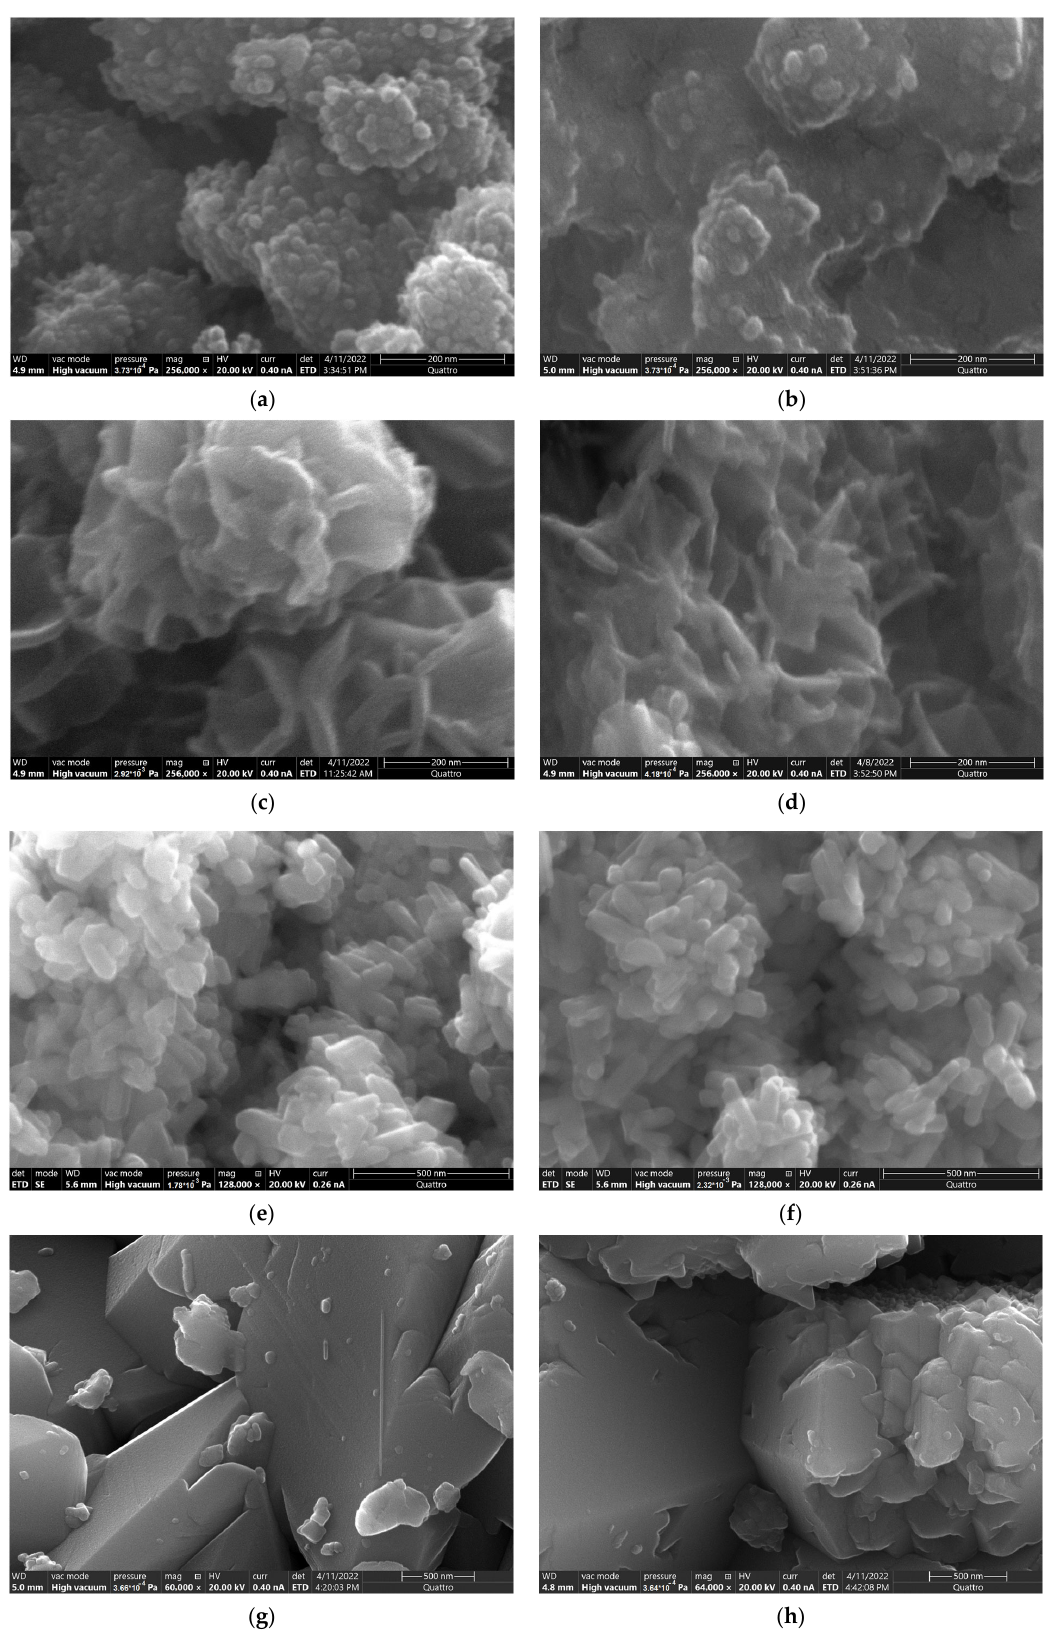
Figure 3. SEM microphotographs of MnO 2 polymorphs’ surfaces before and after Mn adsorption: ( a ) AKH; ( b ) AKH + Mn; ( c ) BIR; ( d ) BIR + Mn; ( e ) CRY; ( f ) CRY + Mn; ( g ) PYR; ( h ) PYR + Mn.